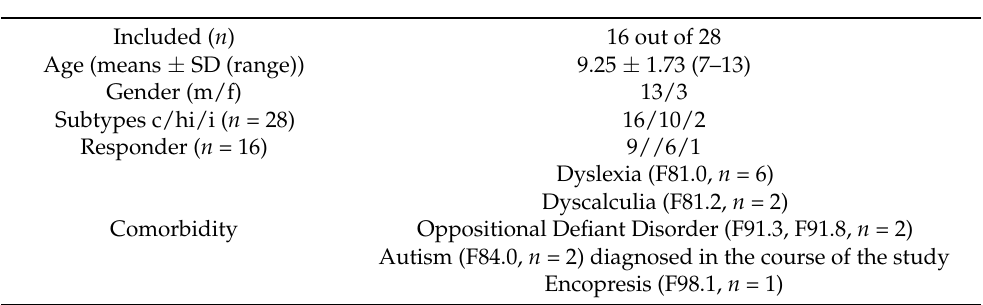
Table 1. Participants’